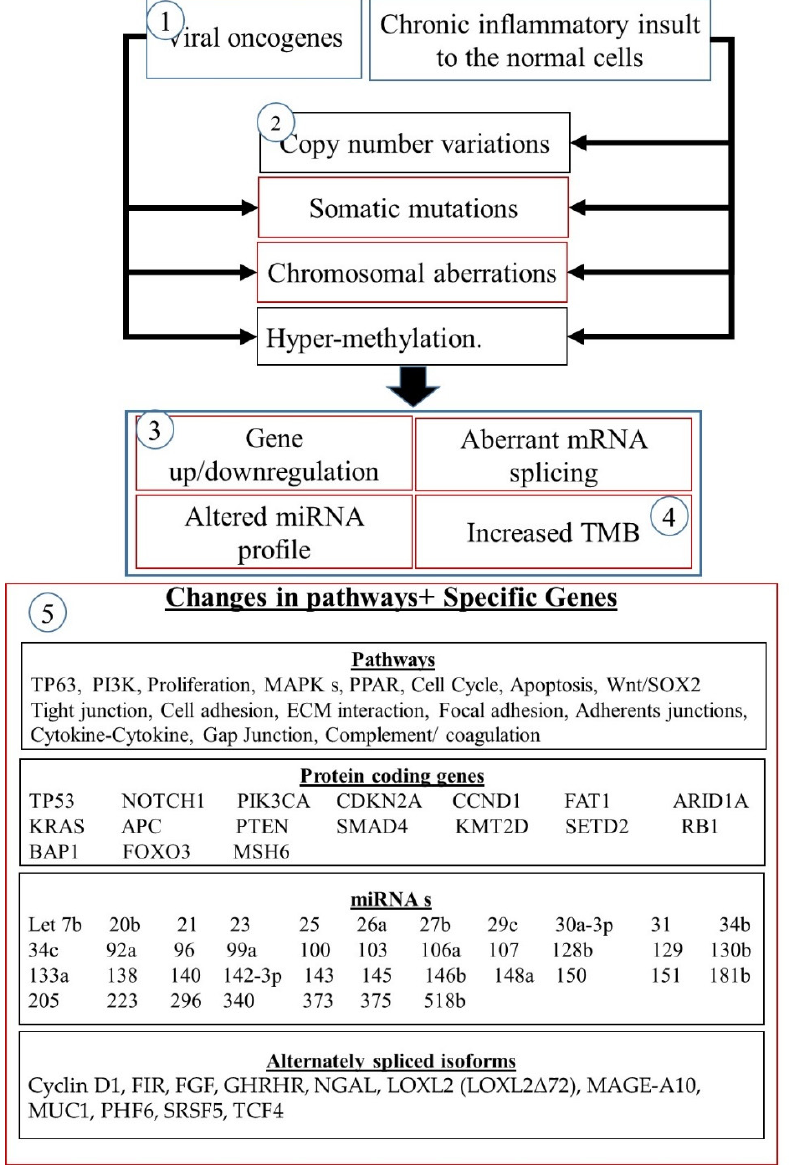
Figure 6. The genomic and molecular changes associated with OSCC. Following genetic damage from viral infection or in the case of OSCC damage to the tissue lining the oesophagus changes can occur at the genetic level relating to somatic mutations, copy number variation, chromosomal aberrations, or epigenetic changes such as hyper-methylation. This can result in changes in the expression patterns of genes or miRNAs as well as changes in the patterns of mRNA splicing. It can also lead to an increased mutational burden. These changes can be used as biomarkers in multiple ways. (1) Infection with oncoviruses serves as indicator for further screening. (2) The presence of patterns of genetic abnormalities can be used as biomarkers. (3) Profiles of alternate transcripts, gene expression, miRNAs used as biomarkers. (4) Tumor mutational burden can be used as a prognostic tool. (5) The presence of specific genes or increased expression of genes involved in certain pathways can be used as a biomarker.